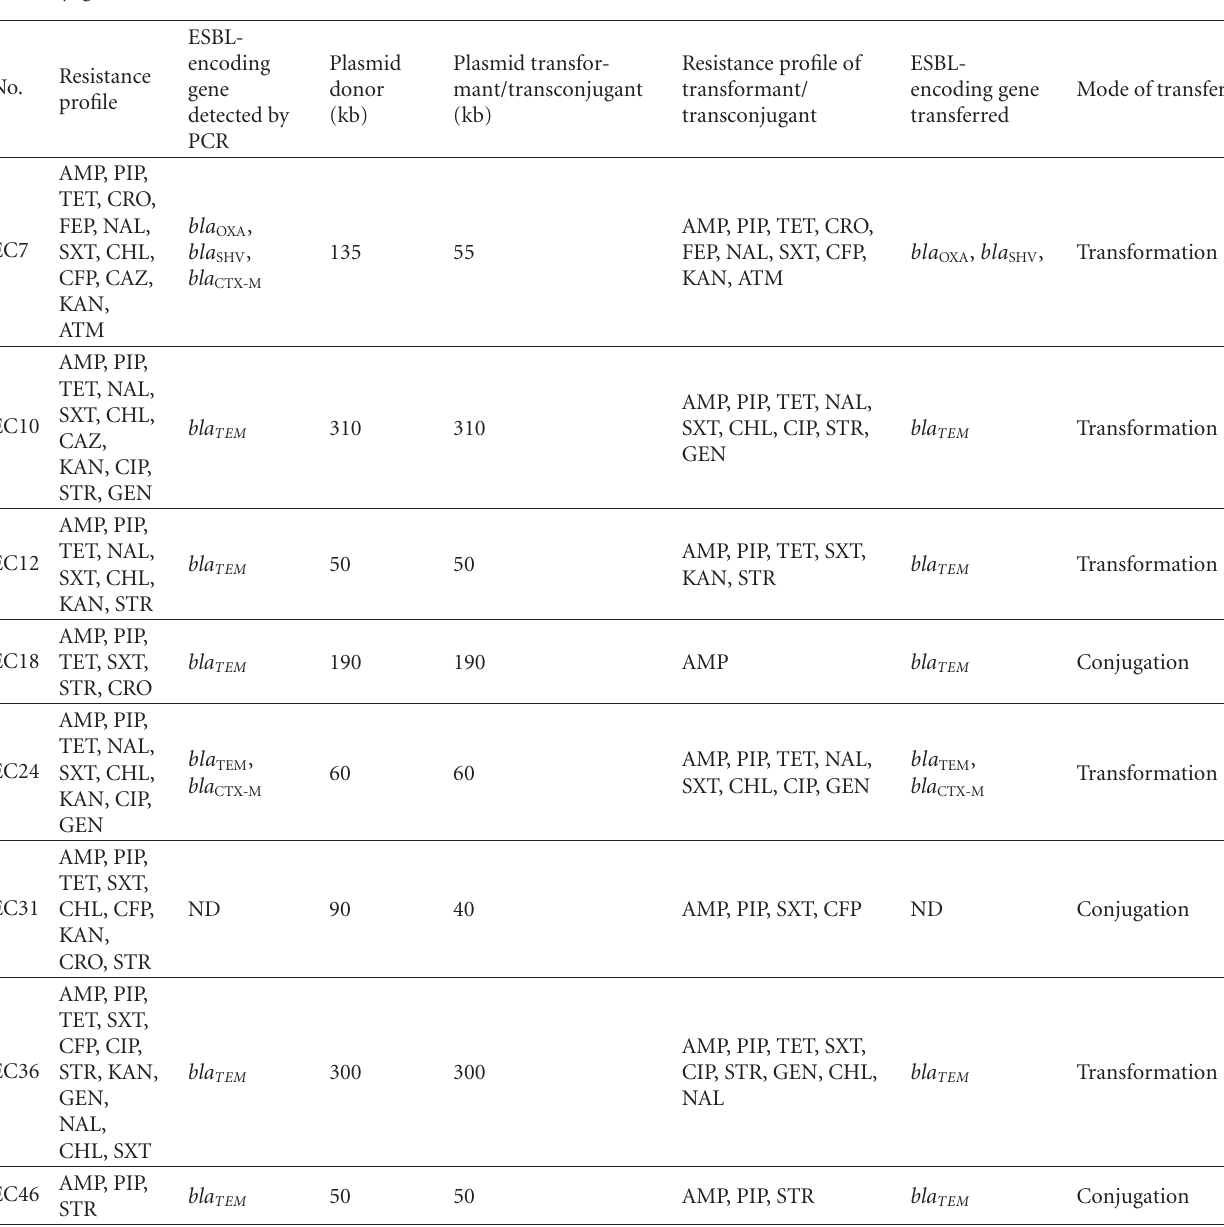
Table 2: Antimicrobial resistance, size of plasmids and ESBL genes detected in the selected donor E. coli isolates, and their respective transconjugants and transformants.